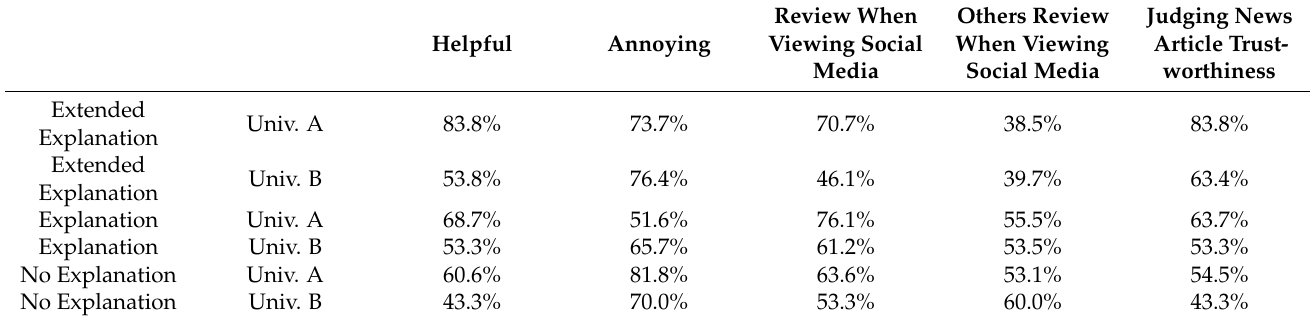
Table 24. Comparison of explanation versus no explanation by school.